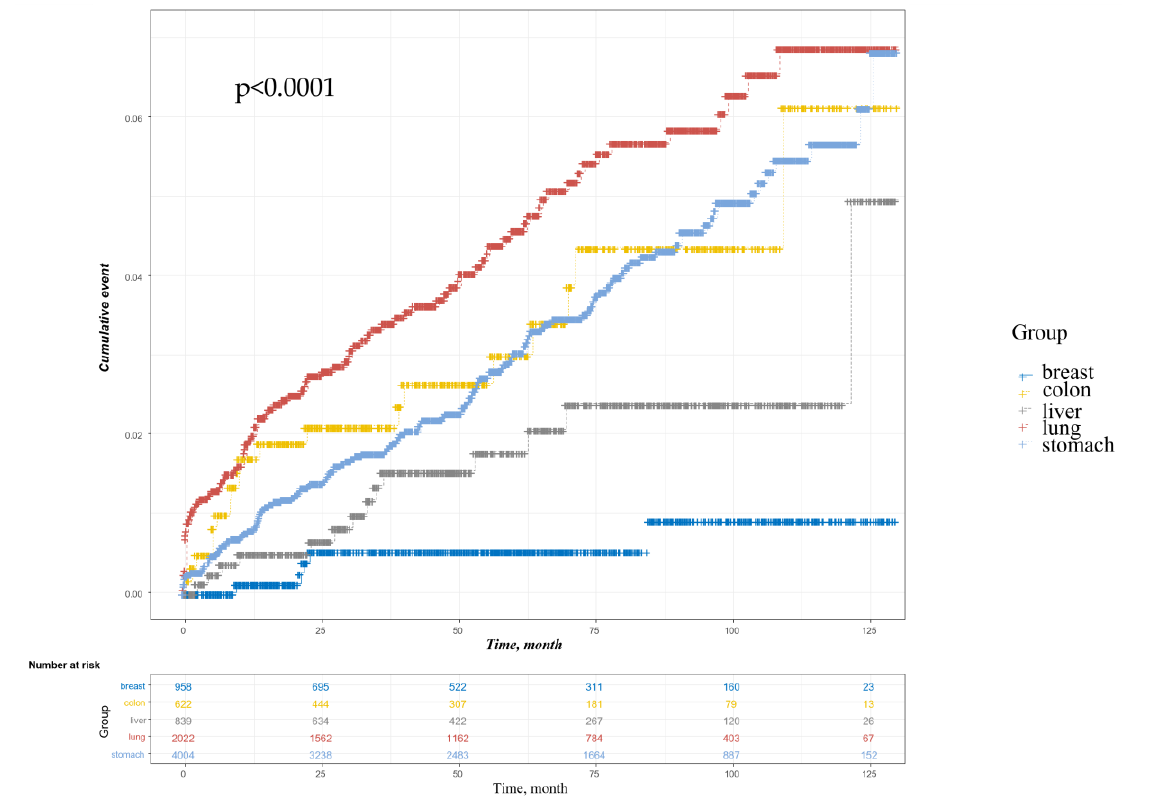
Figure 2. Cumulative event curves for postoperative pneumonia according to cancer type.